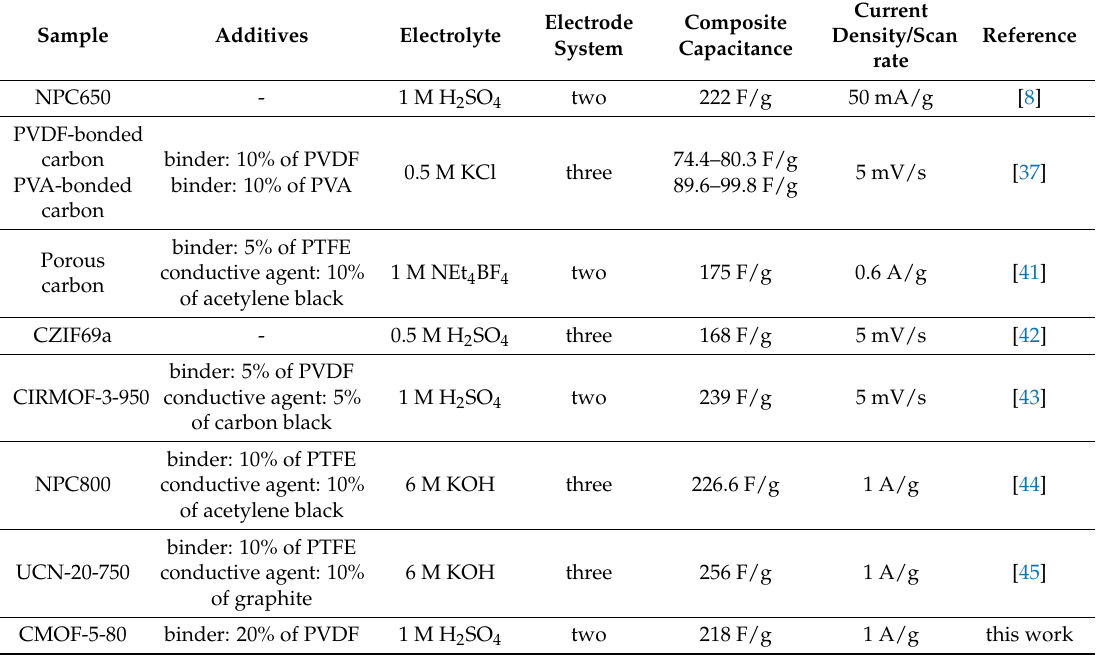
Table 1. The comparison of the capacitance properties between the literature and our carbonized MOF-5.